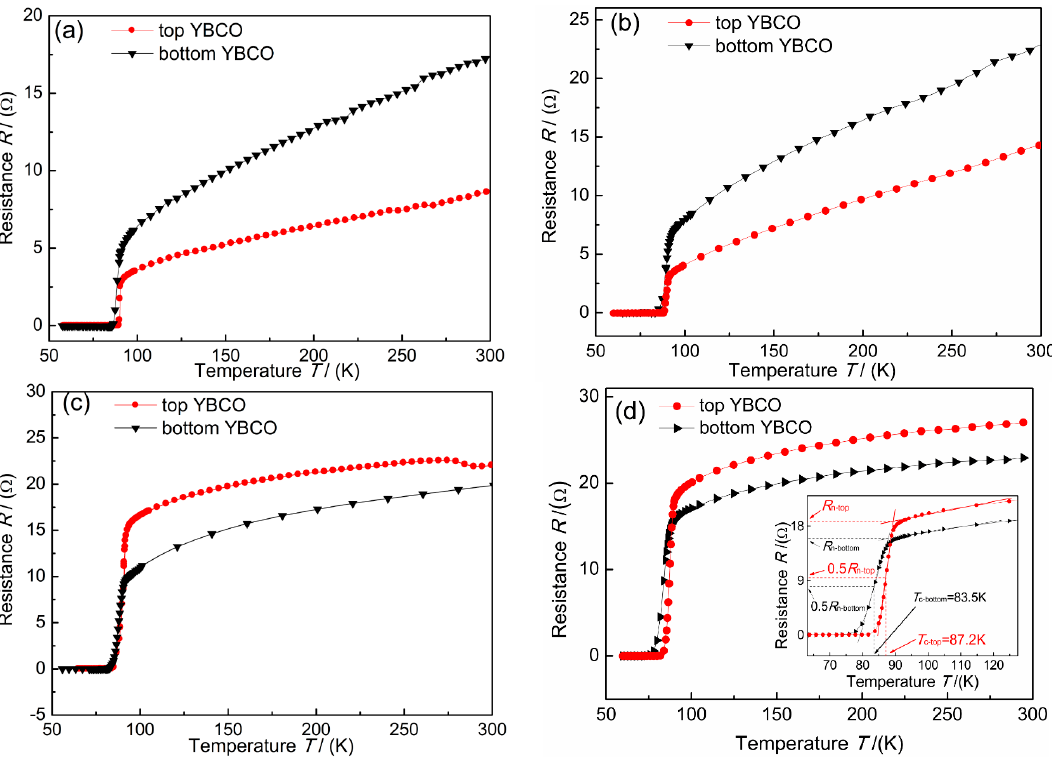
Figure 4. R–T curves of top and bottom YBCO layers in the YBCO/LAO/YBCO trilayer film with different LAO interlayer thickness. ( a ) 0; ( b ) 20 nm; ( c ) 40 nm; ( d ) 70 nm. The inset in ( d ) is a partial enlargement in the superconducting transition region, showing the process for acquiring T c . Table 2. Superconducting transition parameters of the YBCO layers in the YBCO/LAO/YBCO trilayer films.